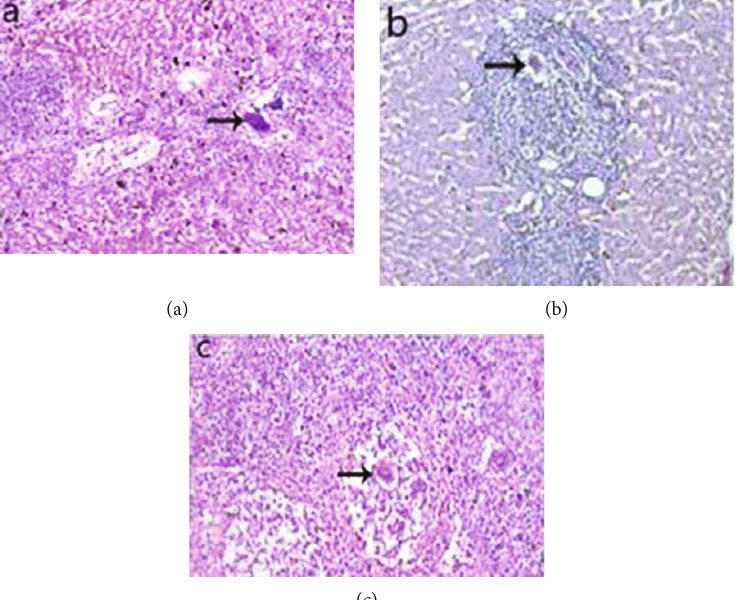
Figure 15: Histological section of infected treated with 400mg/kg Piper nigrum group staining with H&E: (a, b) liver revealed deposited bilharzia ova, surrounded by lympho-epithelioid cellular reaction × 200; (c) spleen showing many fresh deposited and degenerated ova ×